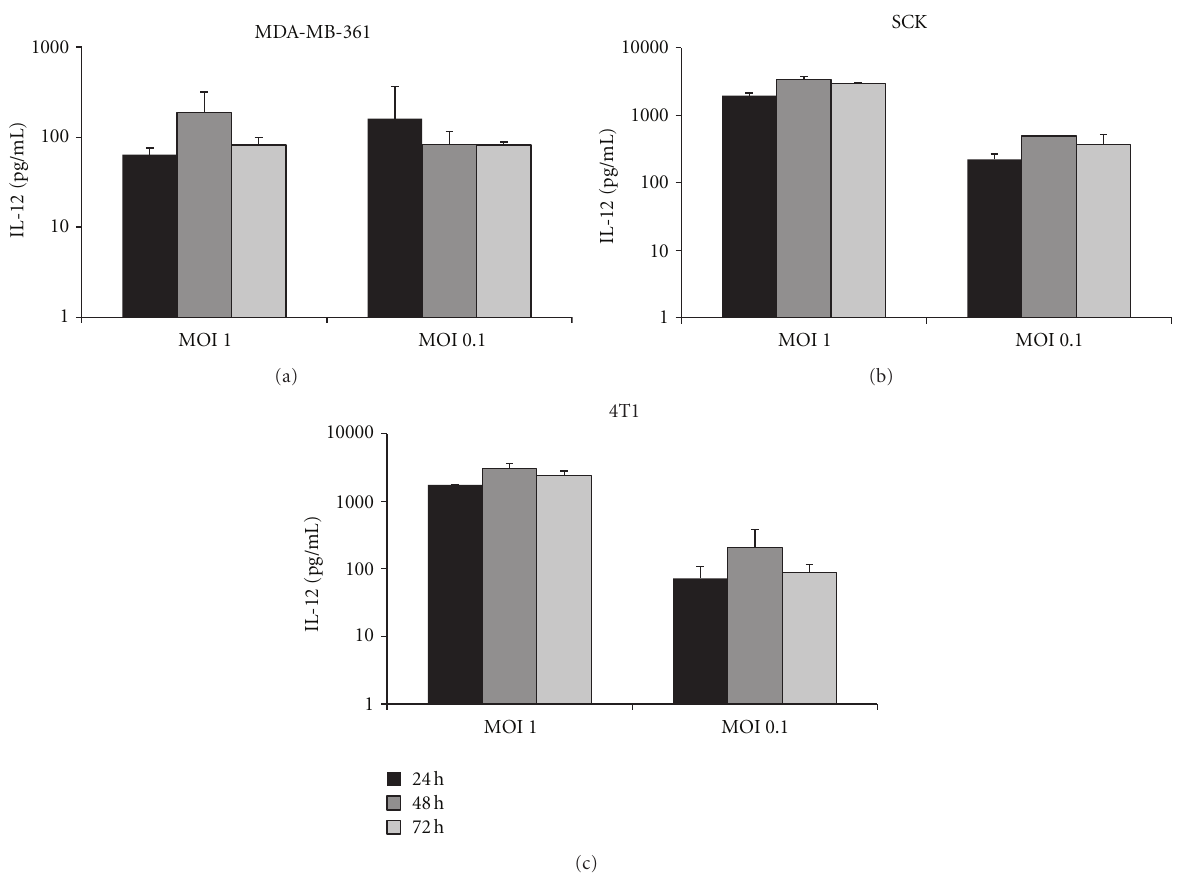
Figure 1: IL-12 production from breast cancer cells infected with M002. 4 × 10 5 human breast cancer cells (MDA-MB-361) or murine mammary carcinoma cells (SCK, 4T1) were infected with M002 at an MOI of 1 or 0.1 PFU/cell. At 24, 48, and 72 h post-infection, media were harvested and subjected to an ELISA specific for the p70 subunit of murine IL-12. No IL-12 was detected from uninfected